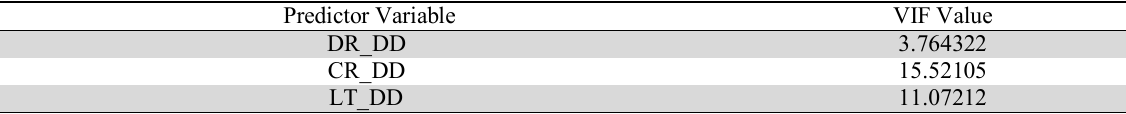
Variance Inflation Factor